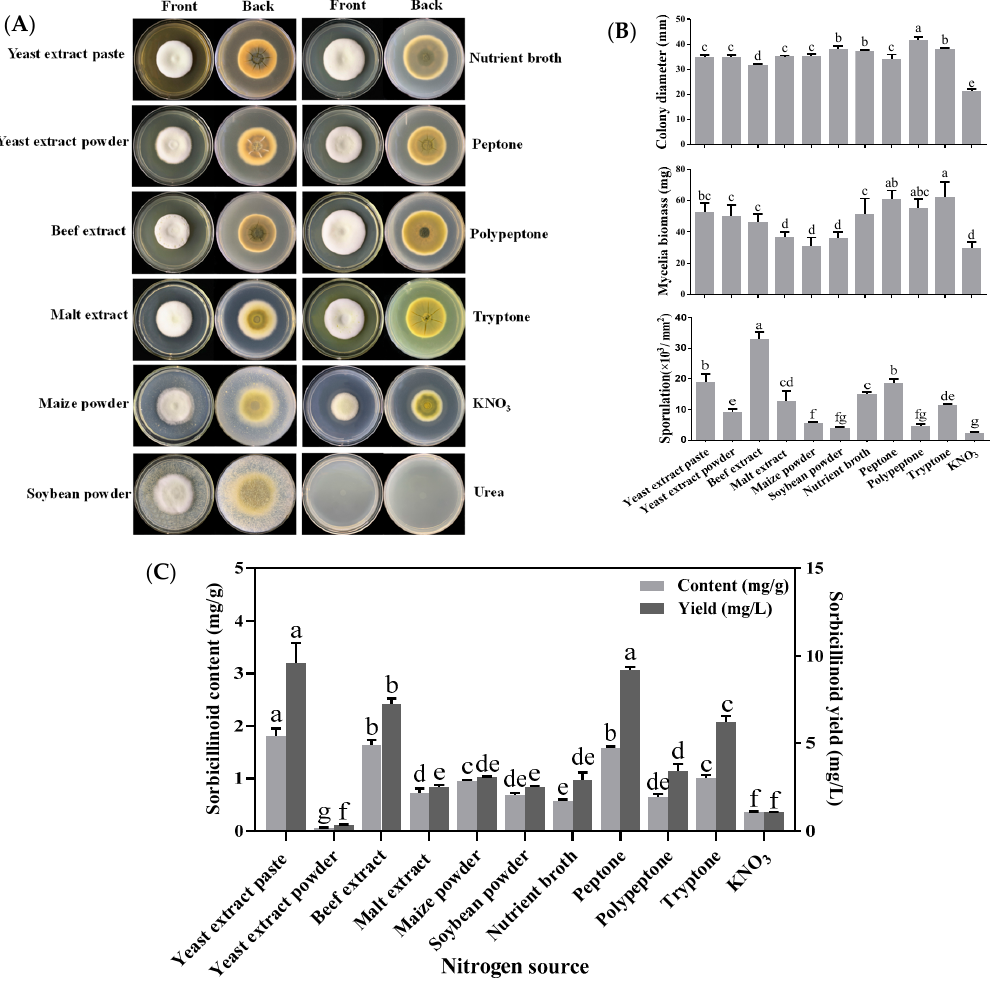
Figure 2. Effects of different nitrogen sources on colony extension, mycelial growth, sporulation and sorbicillinoid production of U. virens . ( A ) Colony morphology of U. virens, cultured for 18 days at 28 ◦ C on PBG medium, supplemented with different nitrogen sources; ( B ) Effects of different nitrogen sources on colony diameter, mycelial biomass and sporulation of U. virens ; ( C ) Effects of different nitrogen sources on sorbicillinoid content (mg/g) and yield (mg/L). Bars represent standard deviations of the means. Different letters mean significant differences according to Duncan’s Multiple Range Test ( p <